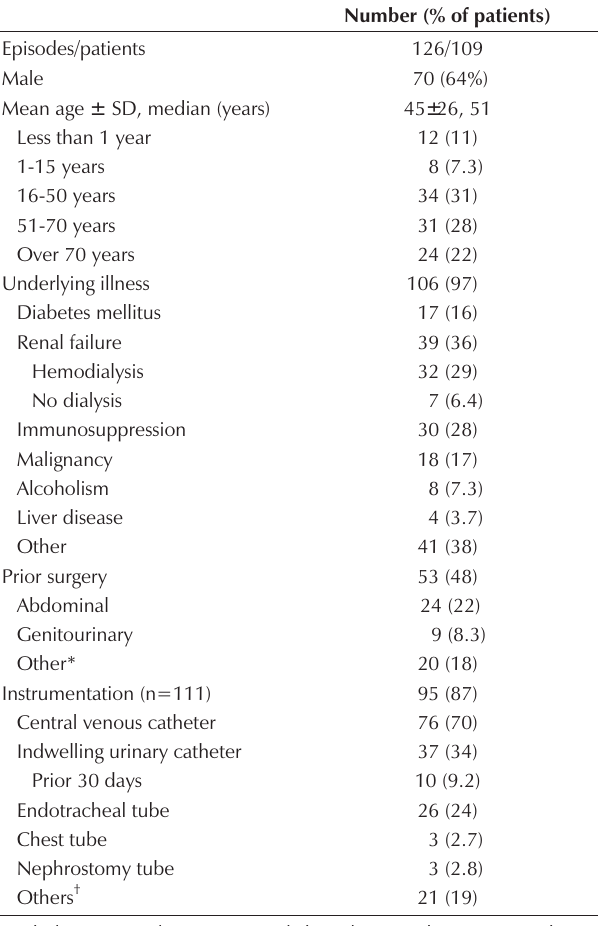
Characteristics of patients with enterococcal bacteremia